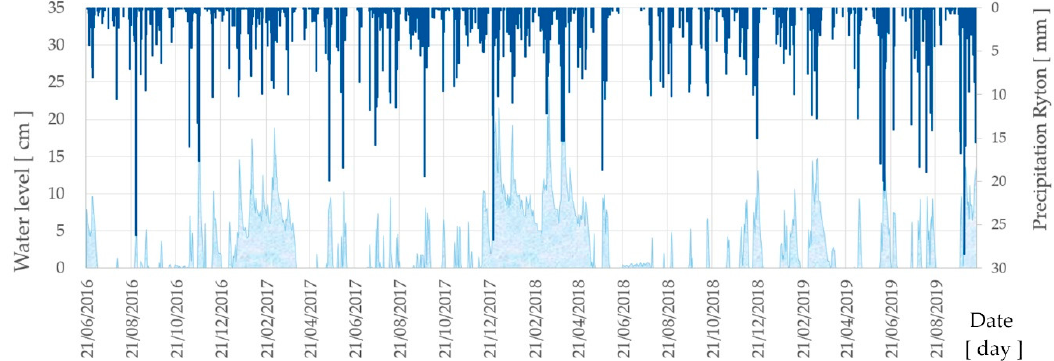
Figure 7. Water level and rainfall registered during this research.